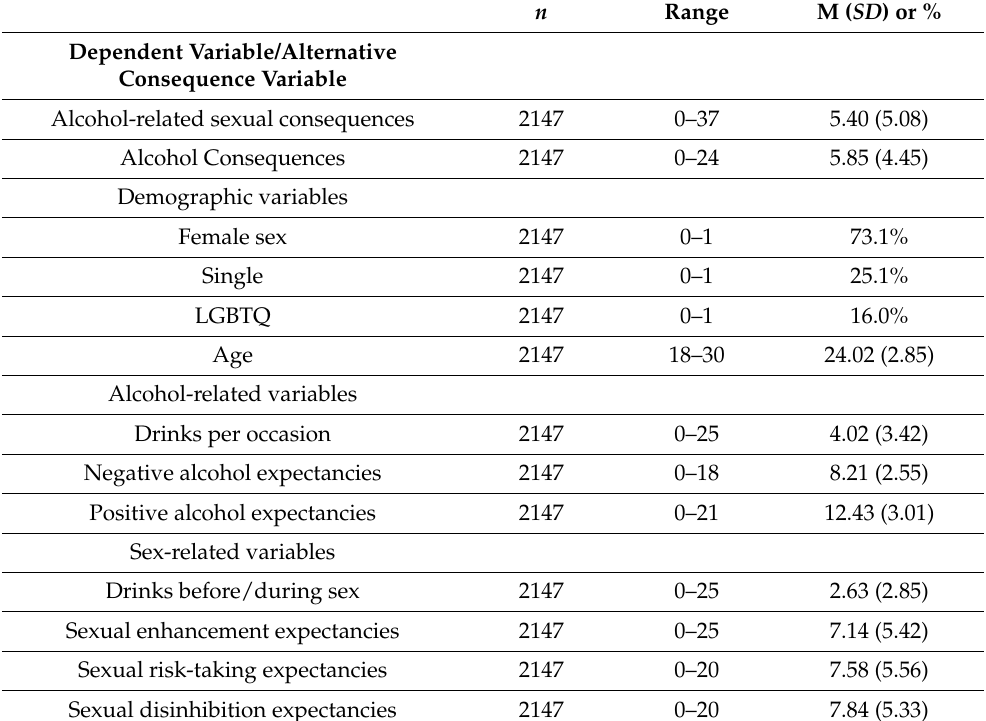
Table 2. Descriptive statistics for variables in the binomial regression